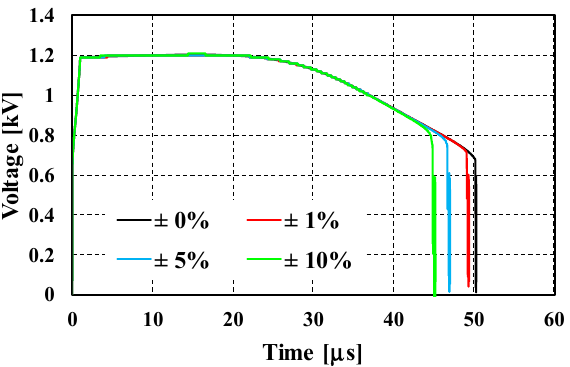
Figure 9. Waveforms of voltage across the MOV element with uniform or nonuniform resistivity distribution from the beginning, calculated using the FDTD method. The variation of resistivity is in a range of ±0% (uniform), ±1%, ±5%, or ±10%.